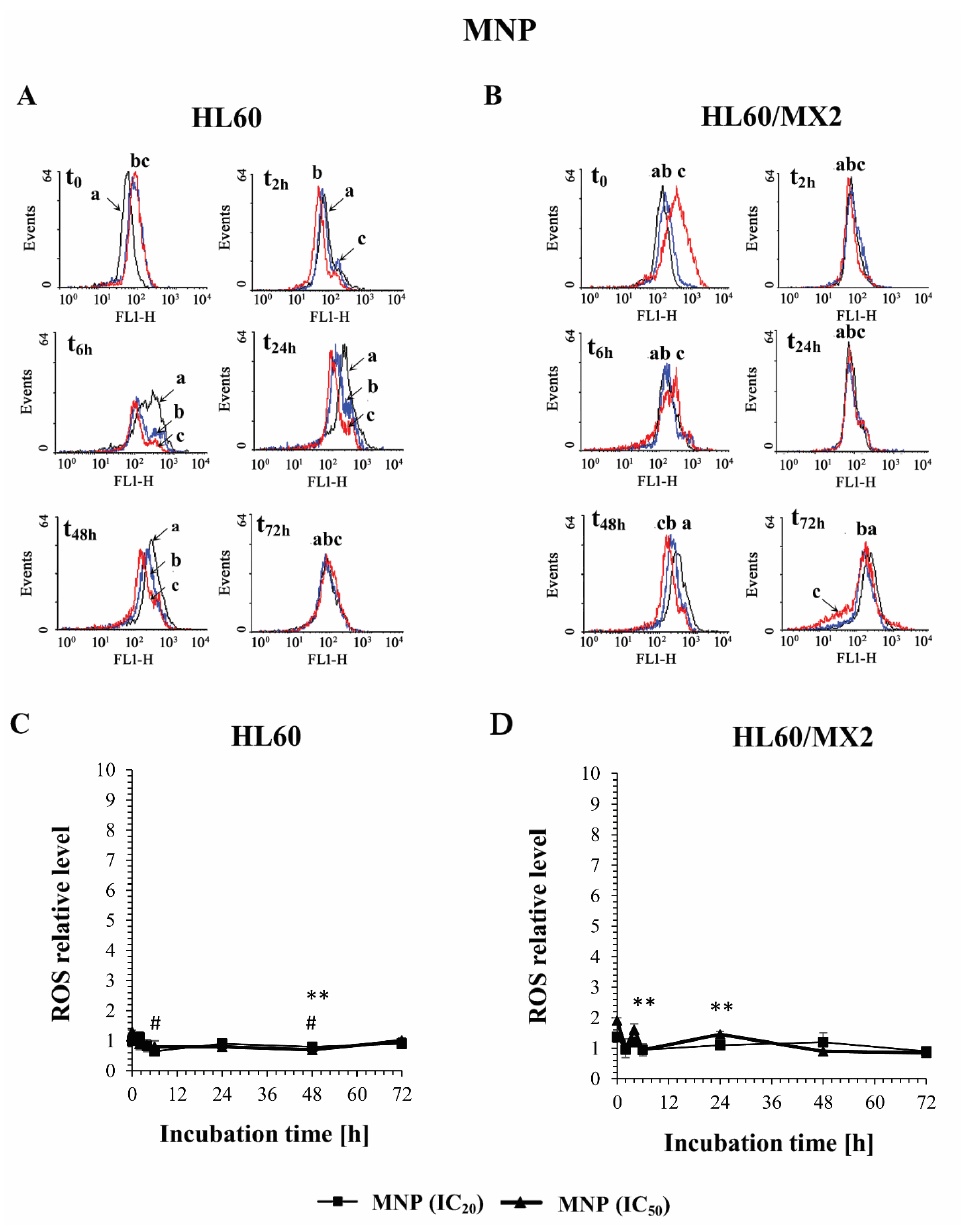
Figure 2. The effect of MNP on the reactive oxygen species (ROS) level in sensitive HL60 ( A , C ) and resistant HL60/MX2 ( B , D ) leukaemia cells. The cells were incubated at 37 °C with MNP used at IC 20 (7.5 µM for HL60 cells and 7.2 µM for HL60/MX2 cells) or at IC 50 (24.3 µM for HL60 cells and 20.5 µM for HL60/MX2 cells), respectively, up to 72 h. The ROS level was determined by flow cytometry with the use of 2′ , 7′ -dichlorofluorescein diacetate ( 2′ , 7′ -DCF-DA). The green fluorescence (FL-1 channel) of 5 × 10 3 events per sample was measured with the use of a laser beam at 530 ± 15 nm ( λ ex = 488 nm). Presented histograms ( A , B ) are representative examples observed for control and treated cell samples (a, black—control cells; b, blue—cells treated with MNP at IC 20 ; and c, red—cells treated with MNP at IC 50 ). The experiment was repeated at least four times (made in triplicate) and the data are given as the mean ± SD values ( C , D ). The significance level of the differences observed (Student’s t -test) between values found for cells treated with MNP at IC 20 ( # p < 0.05) or IC 50 (** p < 0.01), respectively, compared with values found for control